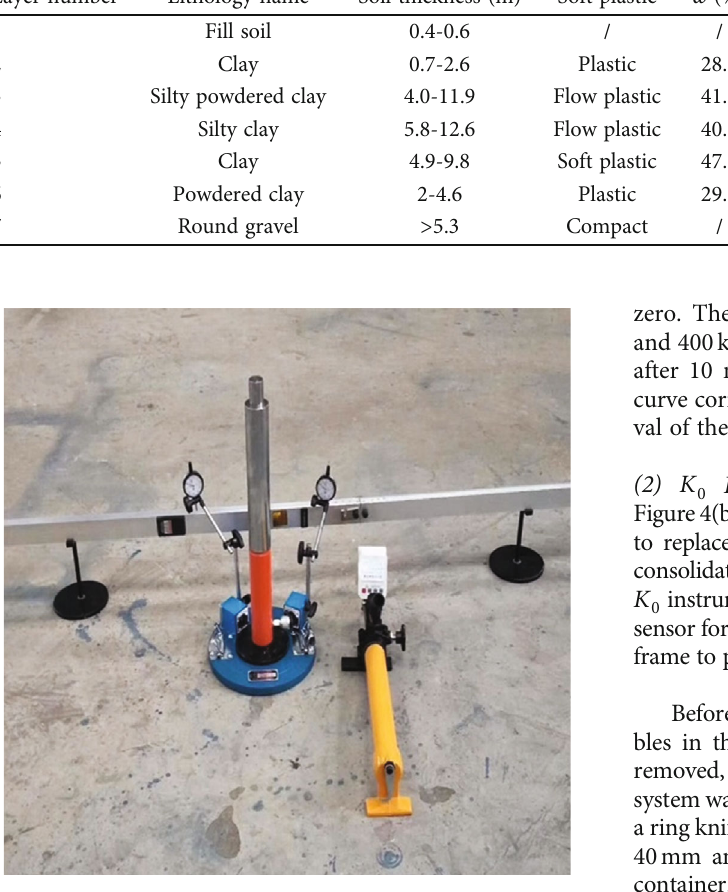
Figure 2: K 30 plate load